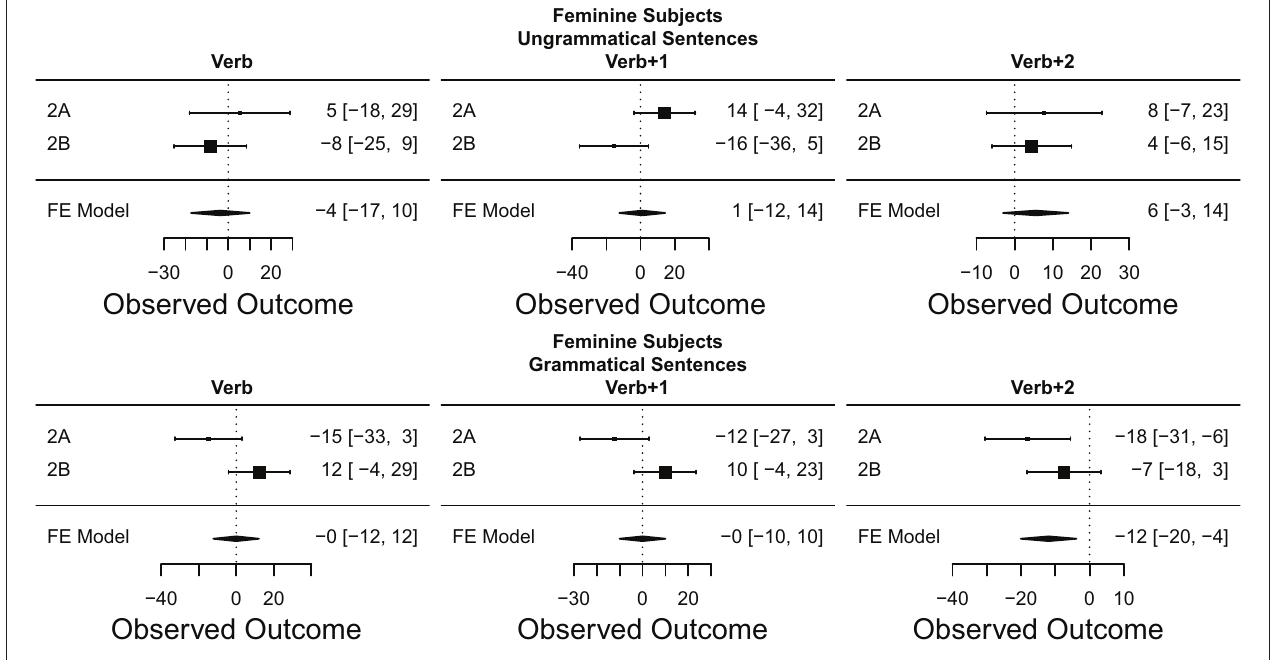
gender and number attraction effects in the region each one first